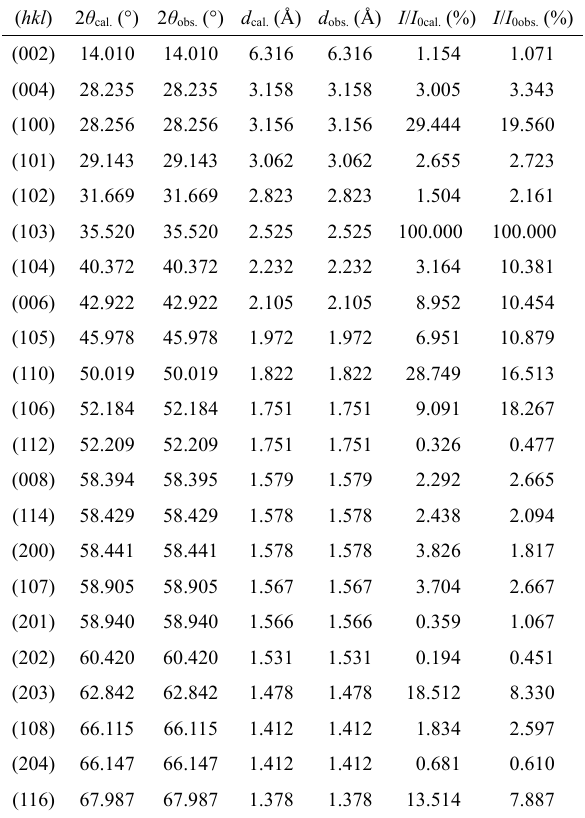
2 θ , d -spacings, and intensities ( I ) of Zr 2 SeB